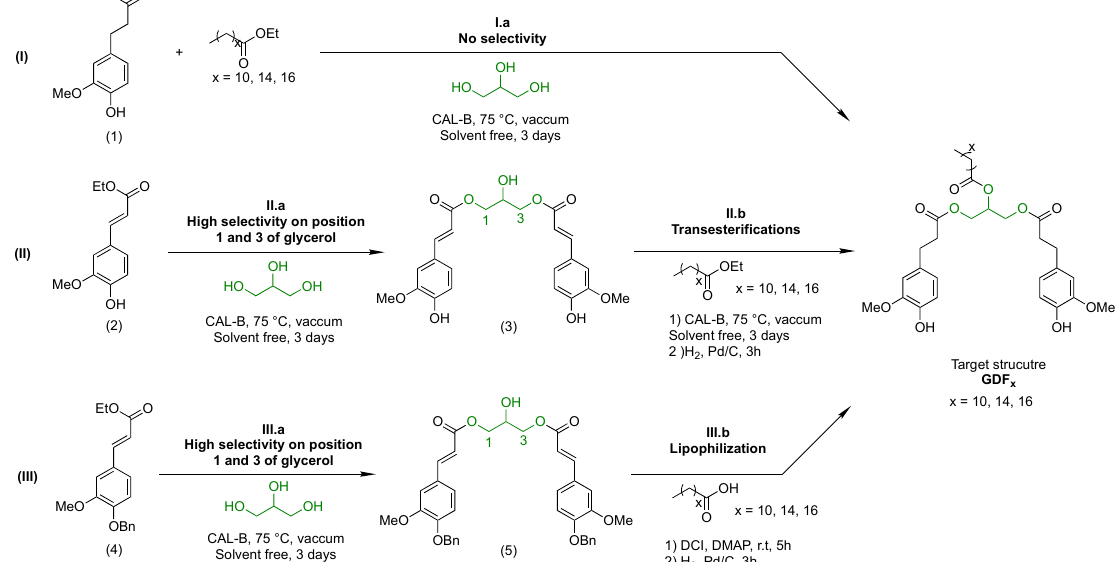
Figure 7. Stoichiometric one pot-one step enzymatic strategy ( I ), one pot-two step strategy ( II ), chemo-enzymatic strategy ( III ), and corresponding yields (I.a: 34%, II.a: 91%, II.b: 40%, III.a: 93%, III.b GDF 10 : 84%, GDF 14 : 81%, GDF 16 : 87%).